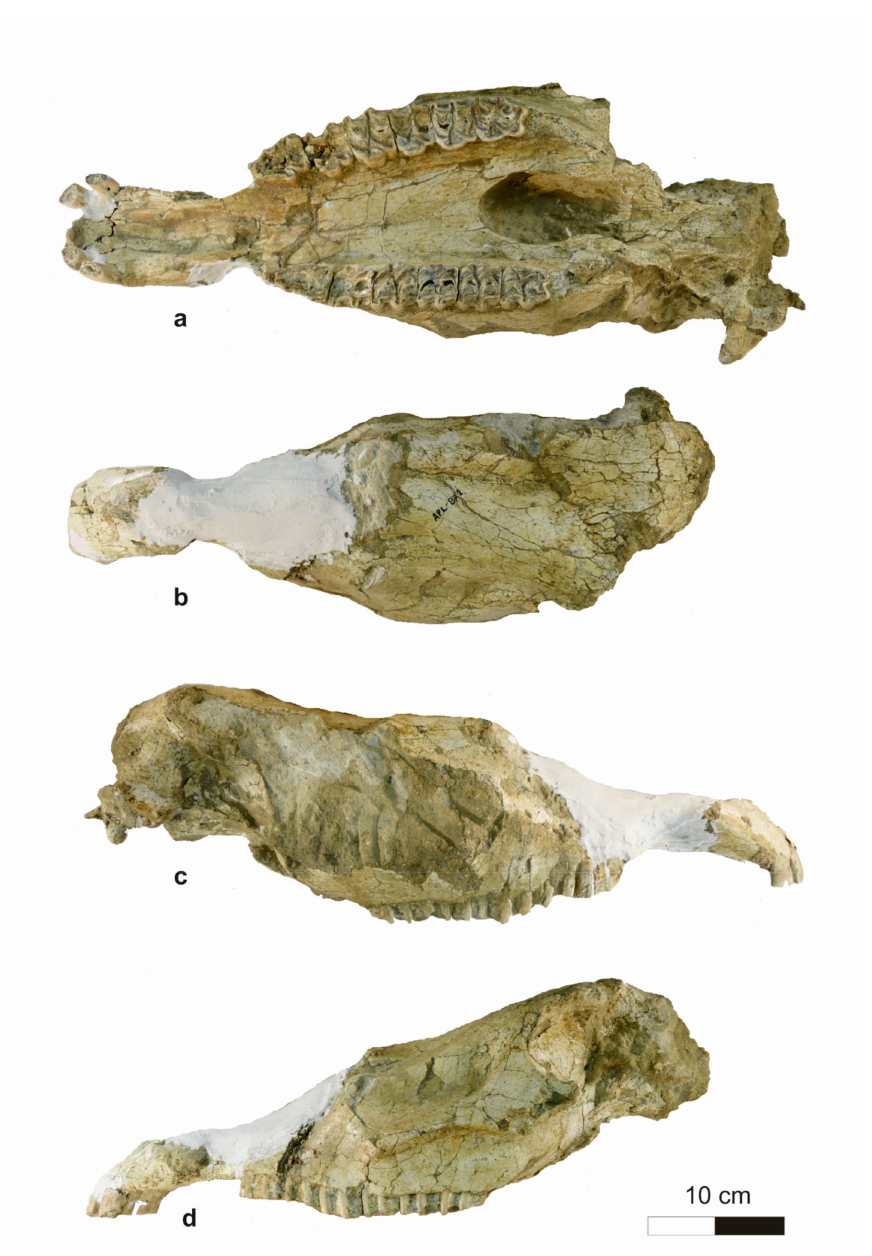
Figure 4. Equus apolloniensis , APL-872; ( a – d ) cranium, ( a ) ventral view, ( b ) dorsal view, ( c ) right lateral view, and ( d ) left lateral